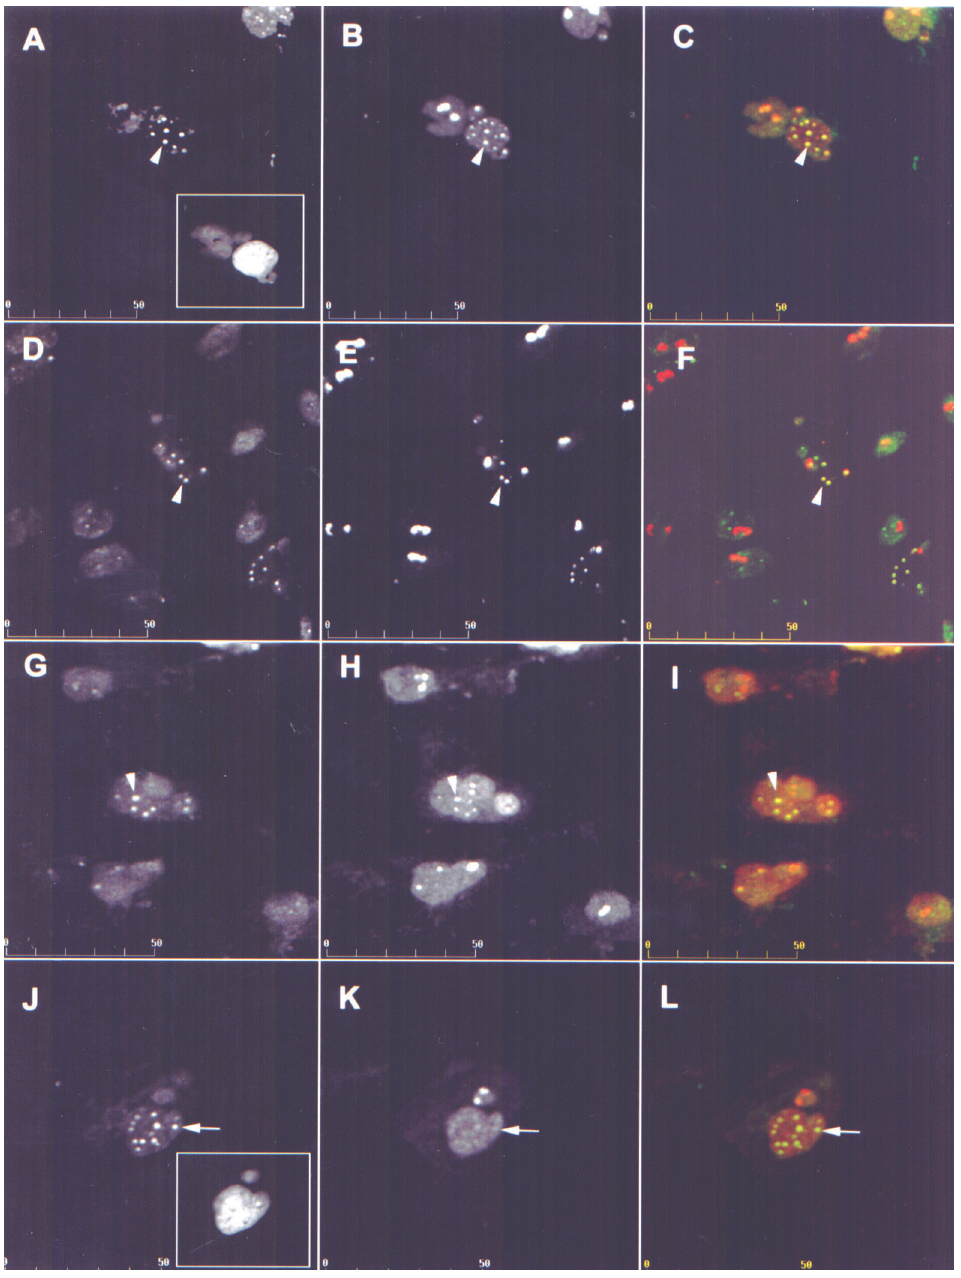
Figure 1. Coilin colocalizes with NOR-90, fibrillarin, and RNA polymerase I autoantigens in micronucleated PtK 2 round bod- ies. Confocal single plane opti- cal sections were obtained through the nuclear region. Pan- els C, F, I , and L at the right column show merged images of the left and middle panels in each row, respectively. Arrow- heads point at the colocalization (yellow/orange areas) of coilin (A) and NOR-90 (B), coilin (D) and fibrillarin (E), and coilin (G) and RNA polymerase I (H). Arrows point at nuclear bodies reacted with anti-coilin antibodies (J) but not with anti-PM/Scl antibodies (K). Round bodies are consis- tently absent in micronuclei dis- playing nucleoli. Insets in A and J show the bisbenzimide stain- ing of the labeled nuclei. Magni- fication bars = 50